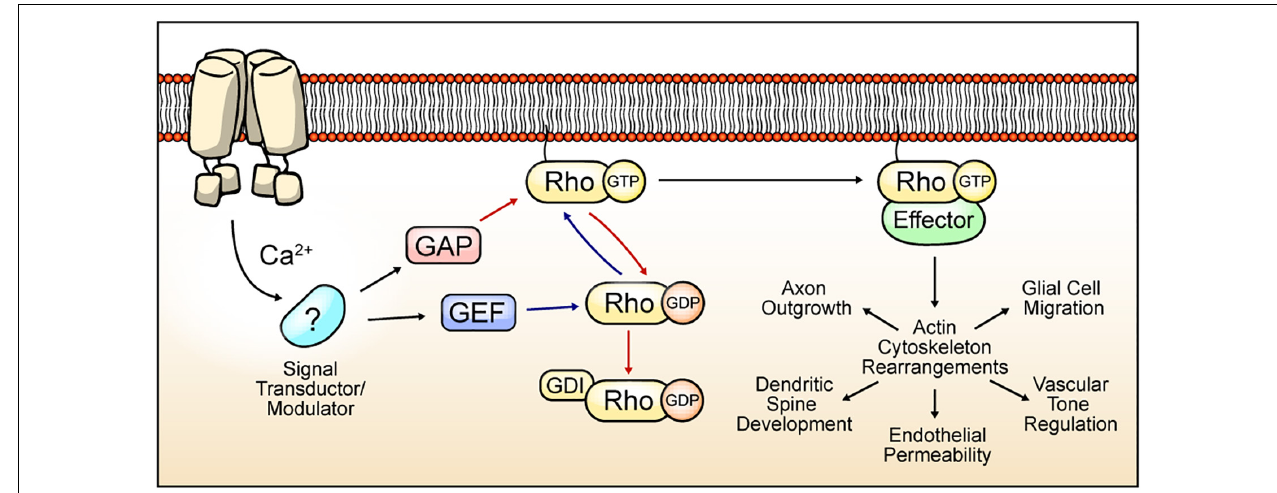
FIGURE 1 | Cyclic Rho GTPase modulation, functions, and TRP channel-mediated regulation hypothesis. Rho GTPases cycle between an active form bound to GTP (blue arrows) and an inactive form that is attached to GDP (red arrows). Binding to guanosine nucleotide is induced by GEF proteins. GAP proteins promote GTPase activity, and GDI proteins preclude GDP exchange to GTP. The active state of Rho GTPase promotes the rearrangement of the actin cytoskeleton by the modulation of several effectors. The actin cytoskeleton mediates multiple processes depending on the cell types. In neurons, axon outgrowth and dendritic spine dynamics regulation. In brain vasculature, Rho GTPases regulate endothelial permeability and vascular tone regulation. Rho GTPases regulates migration in glial cells. TRP channels-mediated Ca 2 + influx regulates signal transductors/modulators, leading to changes in GAP, GEF, or GDI activity, thus promoting Rho GTPases activation/inactivation and actin cytoskeleton